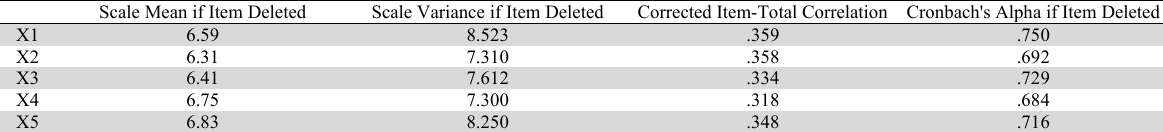
Results of Cronbach’s Alpha Testing of